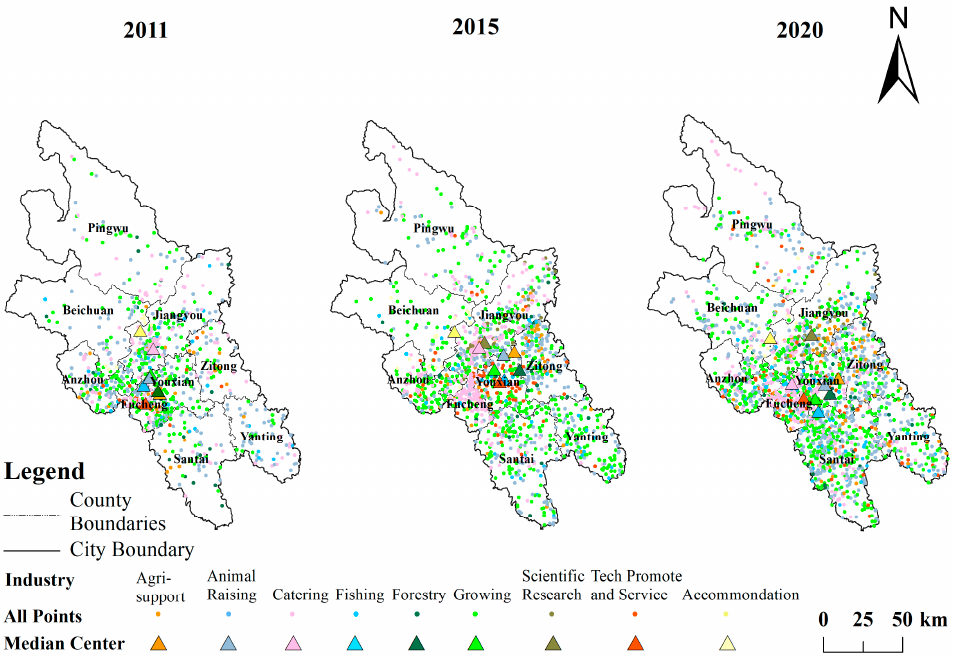
Figure 7. Median center of industry type of rural entrepreneurship in Mianyang in 2011, 2015 and